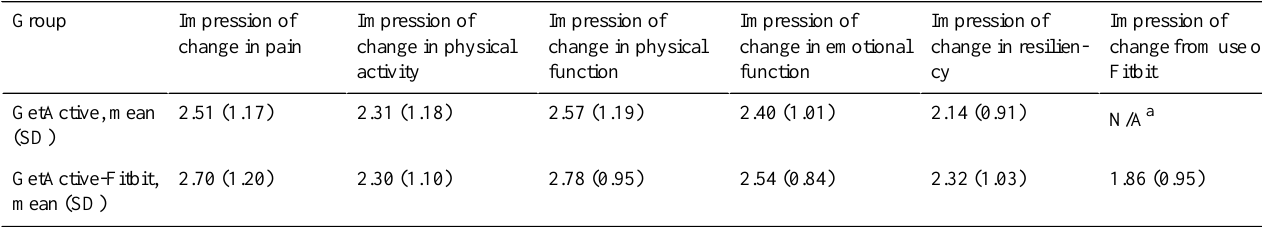
Table 4. Perceived improvement of change (1=very much improved and 7=very much worse).